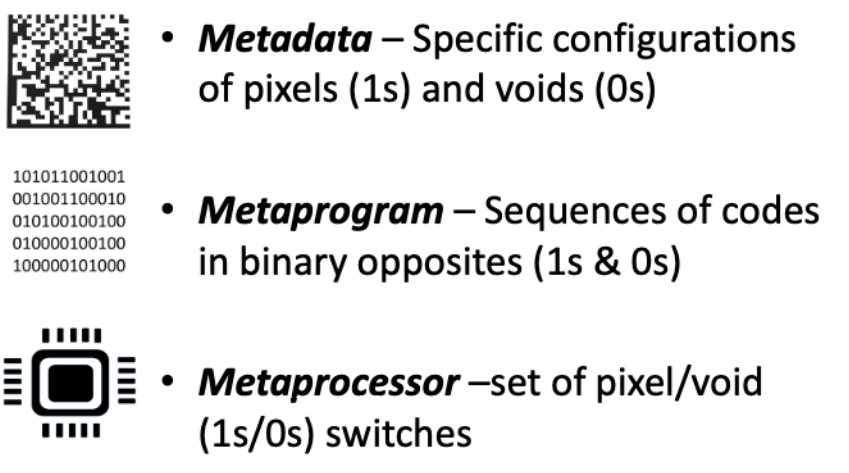
Figure 3. Three faculties of the Platonic computer (metacomputation system) are all composed of binary opposing metaphysical states.